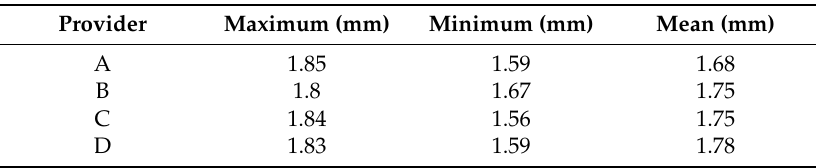
Table 3. Maximum, minimum, and mean of filaments.